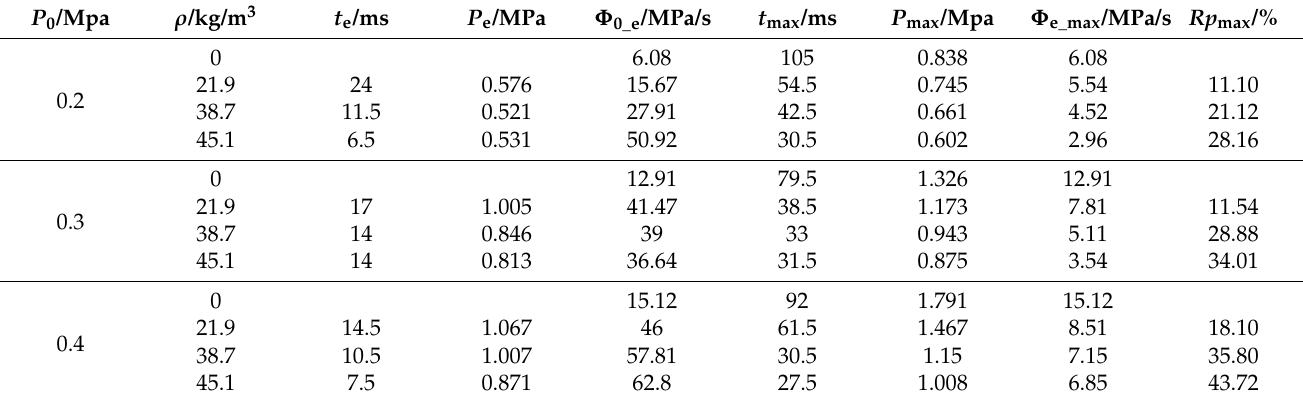
Table 3. Experimental